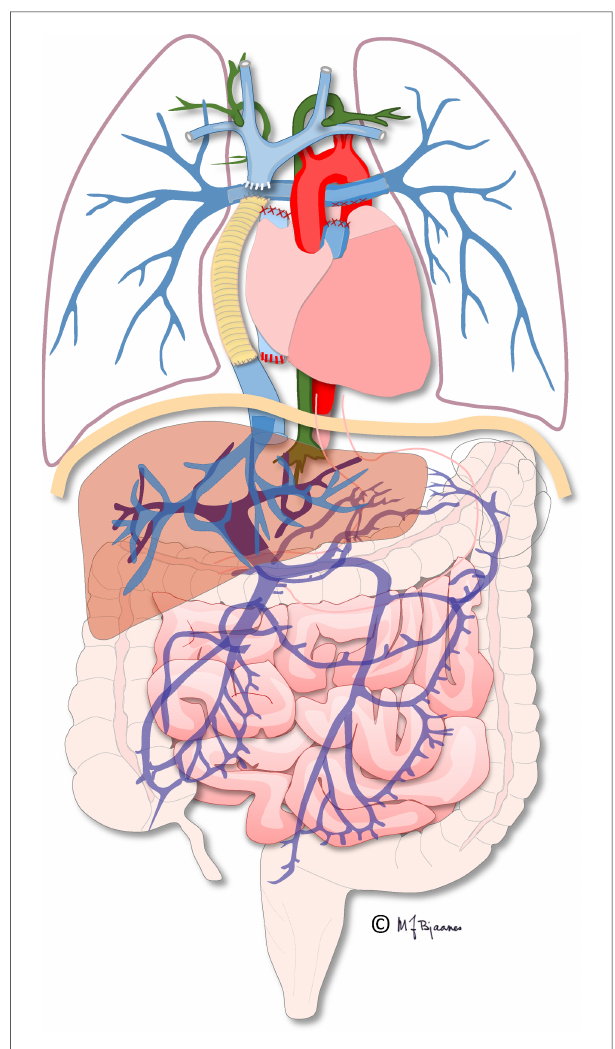
FIGURE 9 Illustration of the total cavopulmonary circulation including the thoracic duct (in green). Illustration created by Michael Bjaanes in collaboration with the Department of Pediatric Cardiology and the Department of Adult Congenital Heart Disease at Oslo University